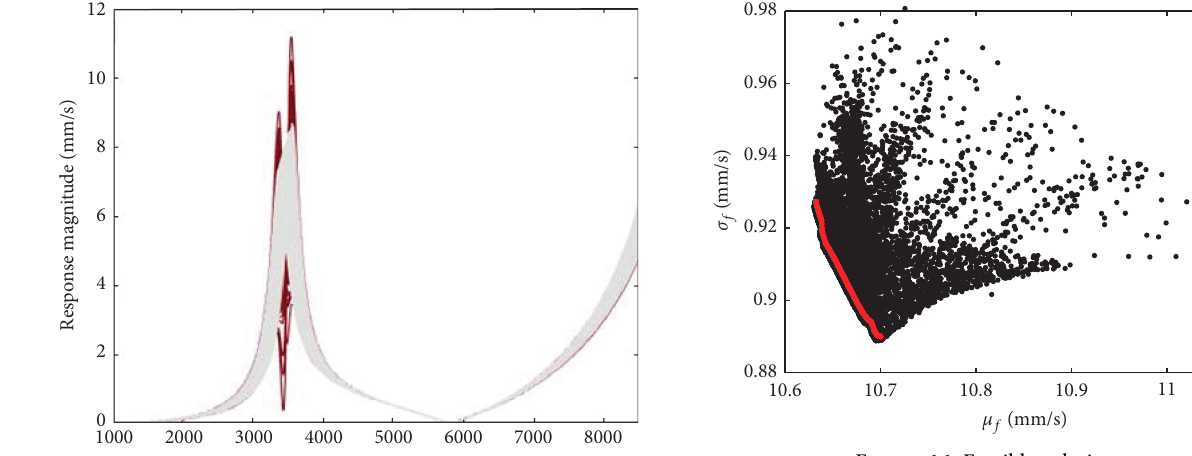
Figure 16: Feasible solutions.